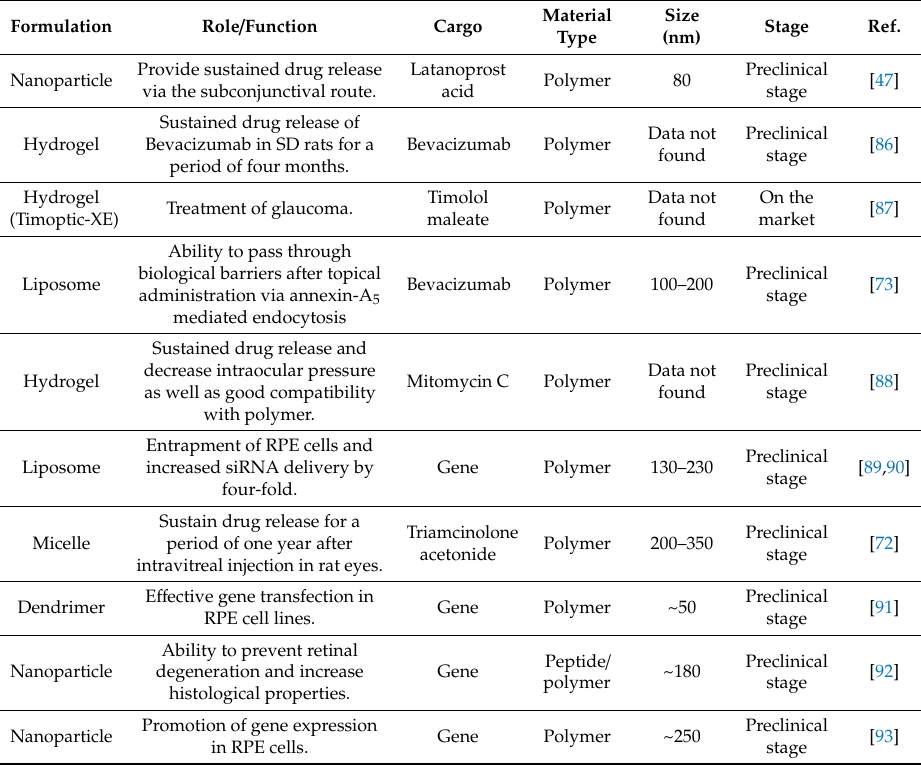
Table 2. The current and traditional strategies based on nanotechnology used in the therapy of glaucoma posterior